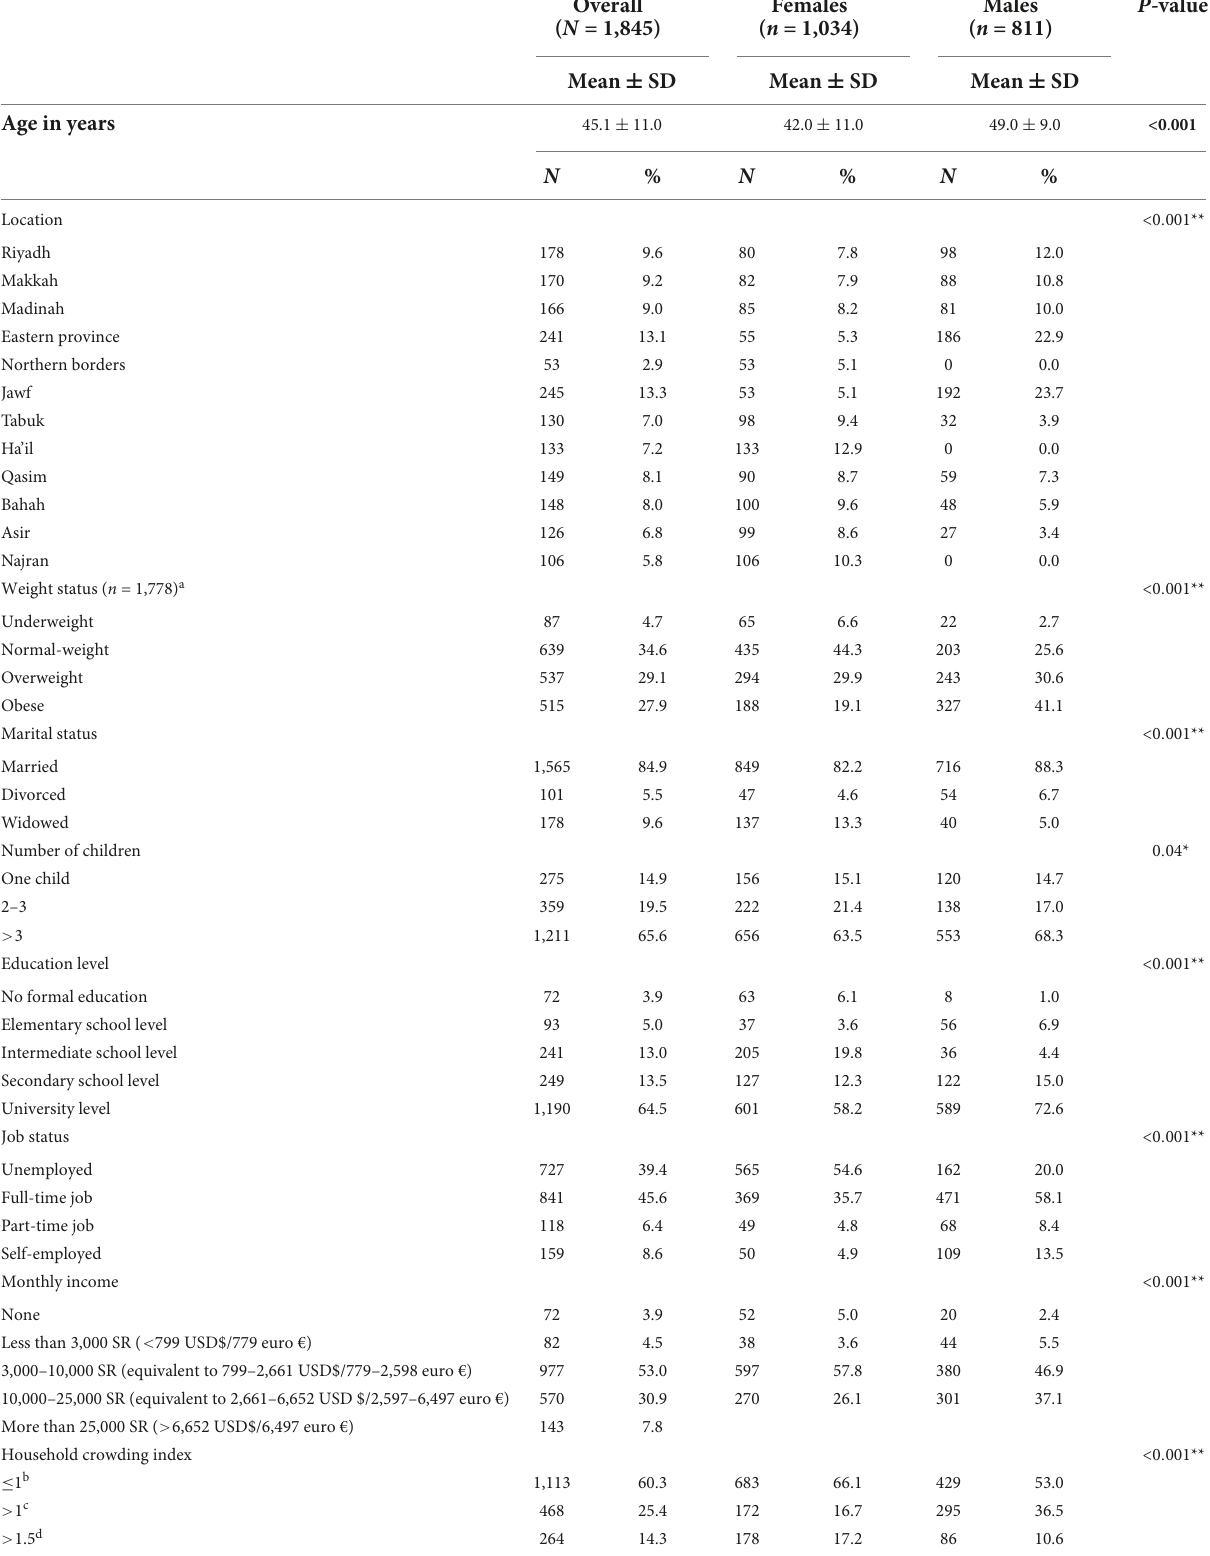
TABLE 2 Parental socio-demographic characteristics and health